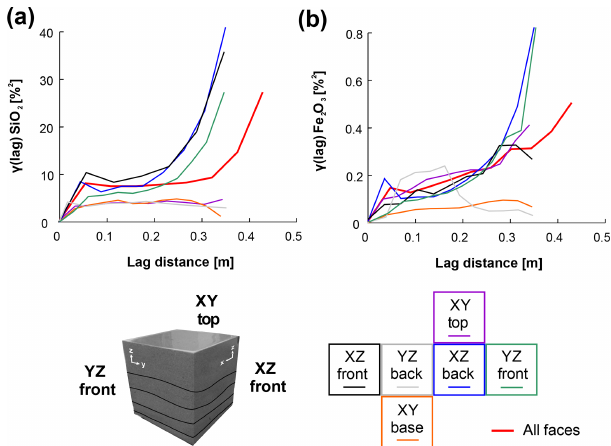
Figure 9. Empirical semivariograms of the mass fraction of SiO 2 (a) and Fe 2 O 3 (b) in rock cube OSB1_c grouped by the in- vestigated rock